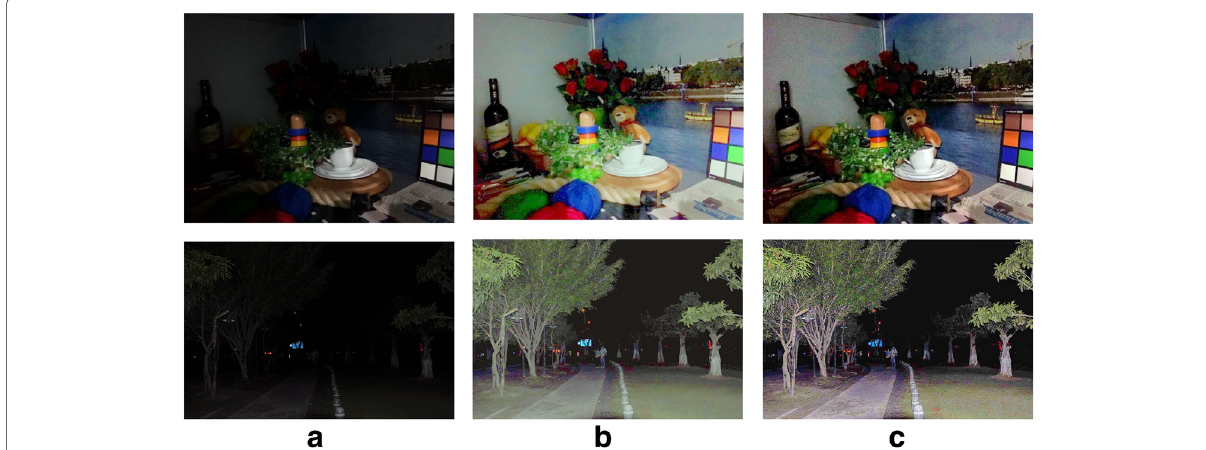
Fig. 11 Comparison of the proposed method with customized sigmoid function-based multi-scale retinex (MSR) [11]. a Input images. b Enhanced images with customized sigmoid function-based multi-scale retinex (MSR) [11]. c Enhanced image with the proposed method